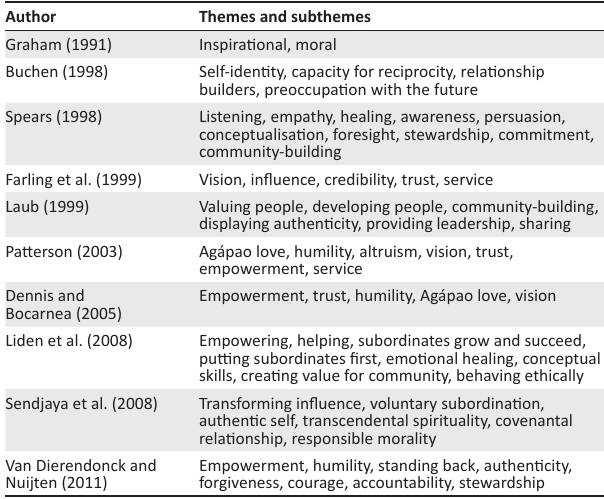
TABLE 1: Servant leadership – Dominant evolutionary